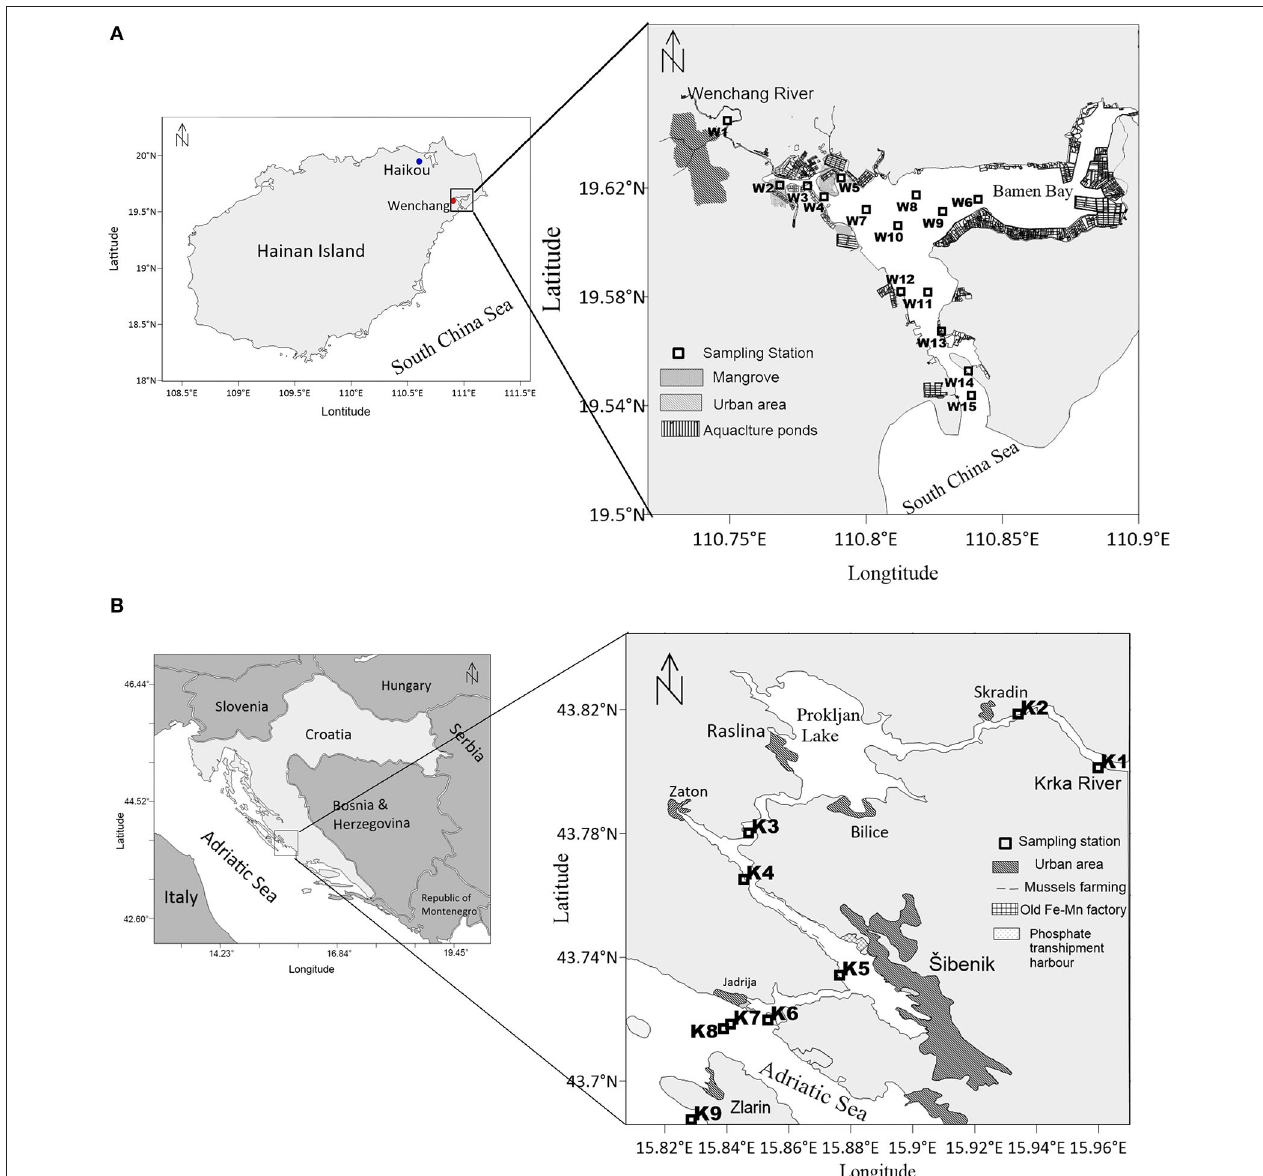
FIGURE 1 | Study areas and sampling stations in (A) the Wenchang River Estuary (WRE) and (B) the Krka River Estuary